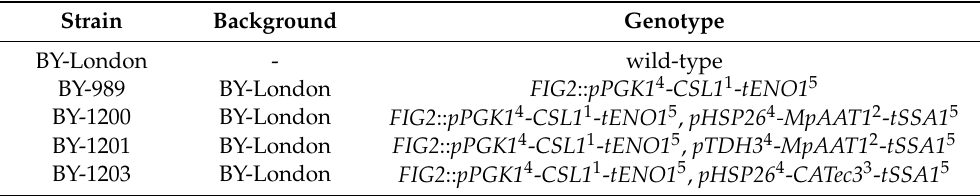
Table 1. Genotypes of strains created/used in Phase I.